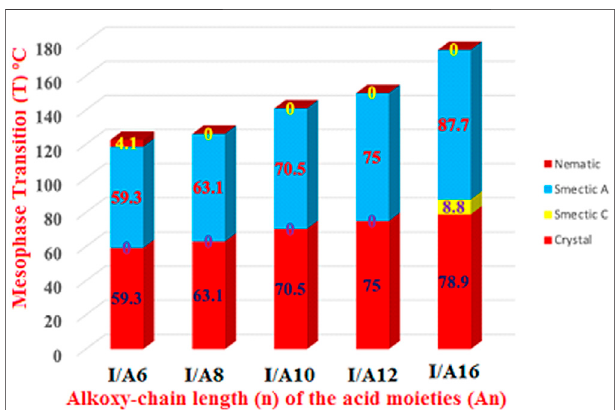
FIGURE 9 | Effect of the terminal length of alkoxy-acid chain (n) on mesomorphic behaviour of 1:1 SMHBCs, I/An.